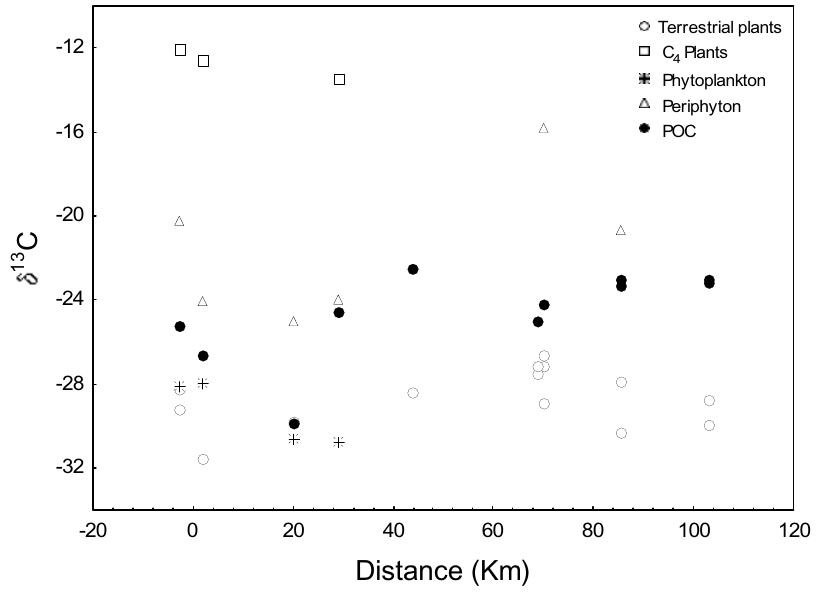
Fig. 3 – Spatial variation of δ 13 C in leaves of the riparian vegetation, C4 plants, zooplankton, periphyton, POC in the area of influence of Corumbá Reservoir: 0 = dam; distance > 0 = upstream; distance < 0 = downstream (source: Benedito-Cecilio et al.